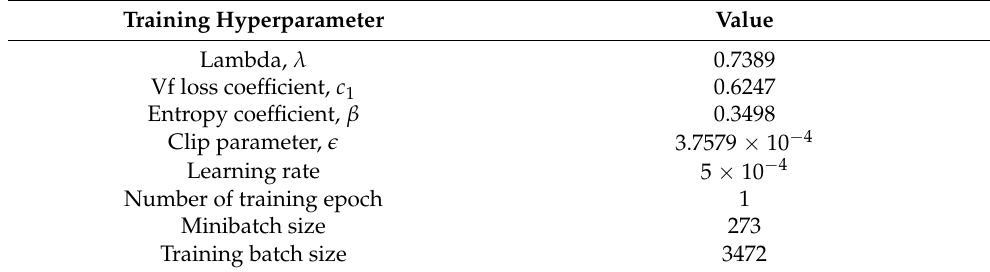
Table 6. Hyperparameters used for